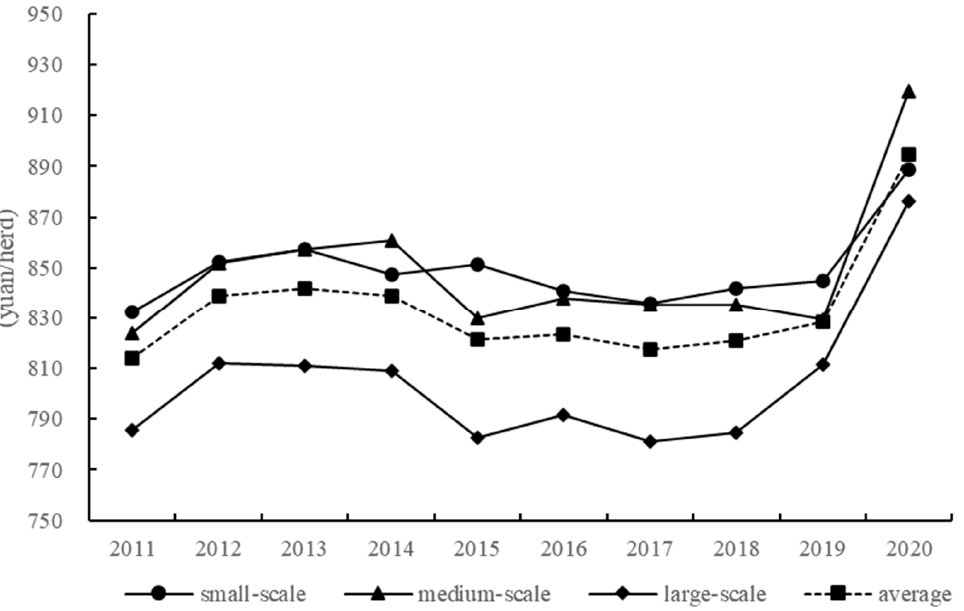
Figure 1. Annual feed costs of hog production of different scales in China from 2011 to 2020.